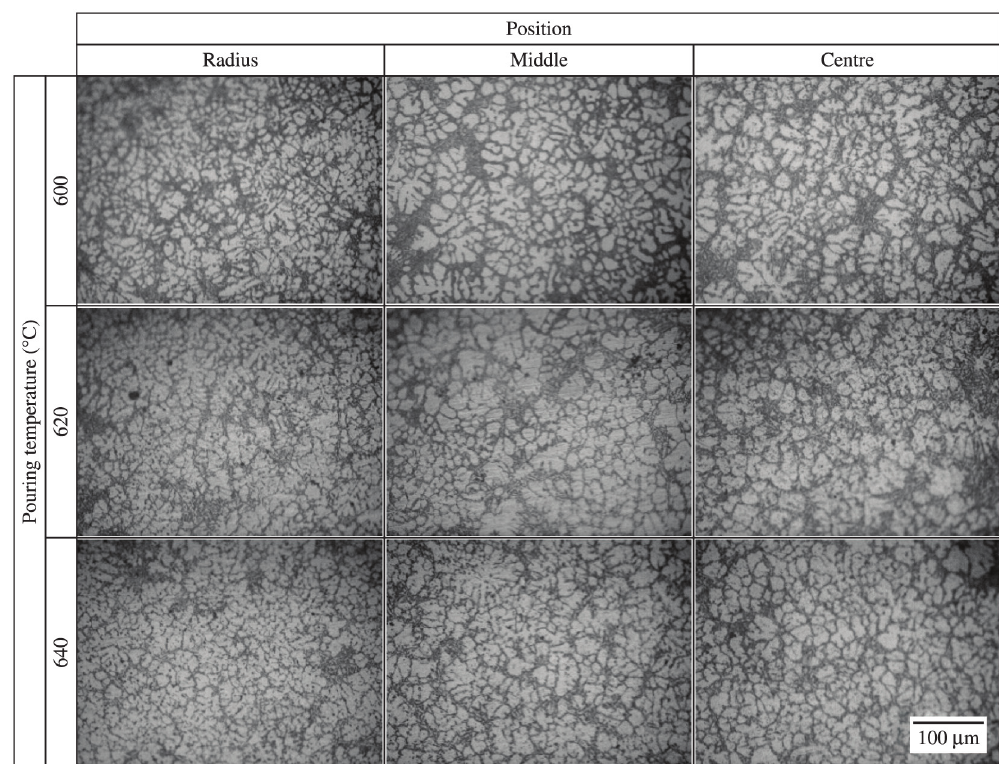
Figure 7. Microstructures of CS cast ingot without